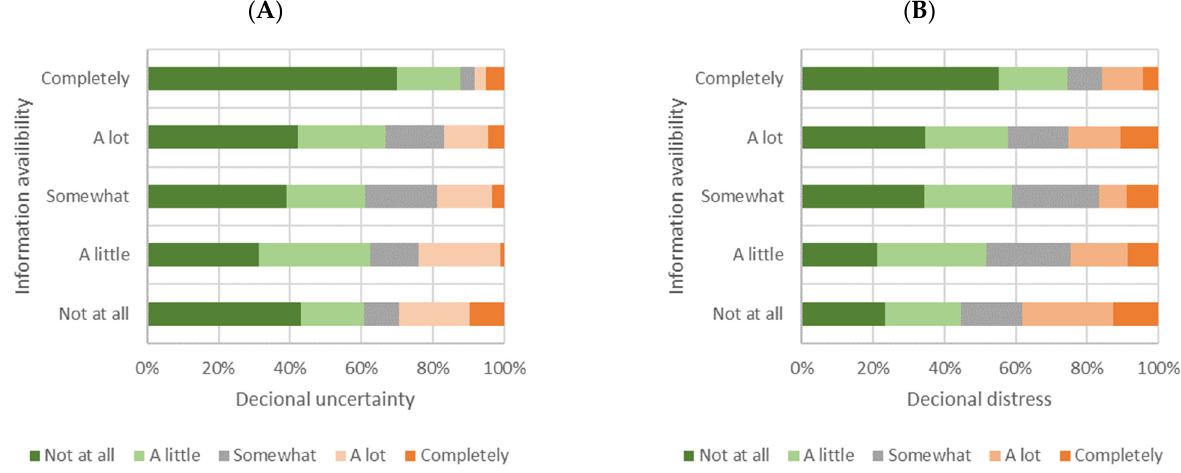
Figure 3. Influence of information availability on ( A ) decisional uncertainty and ( B ) decisional distress.